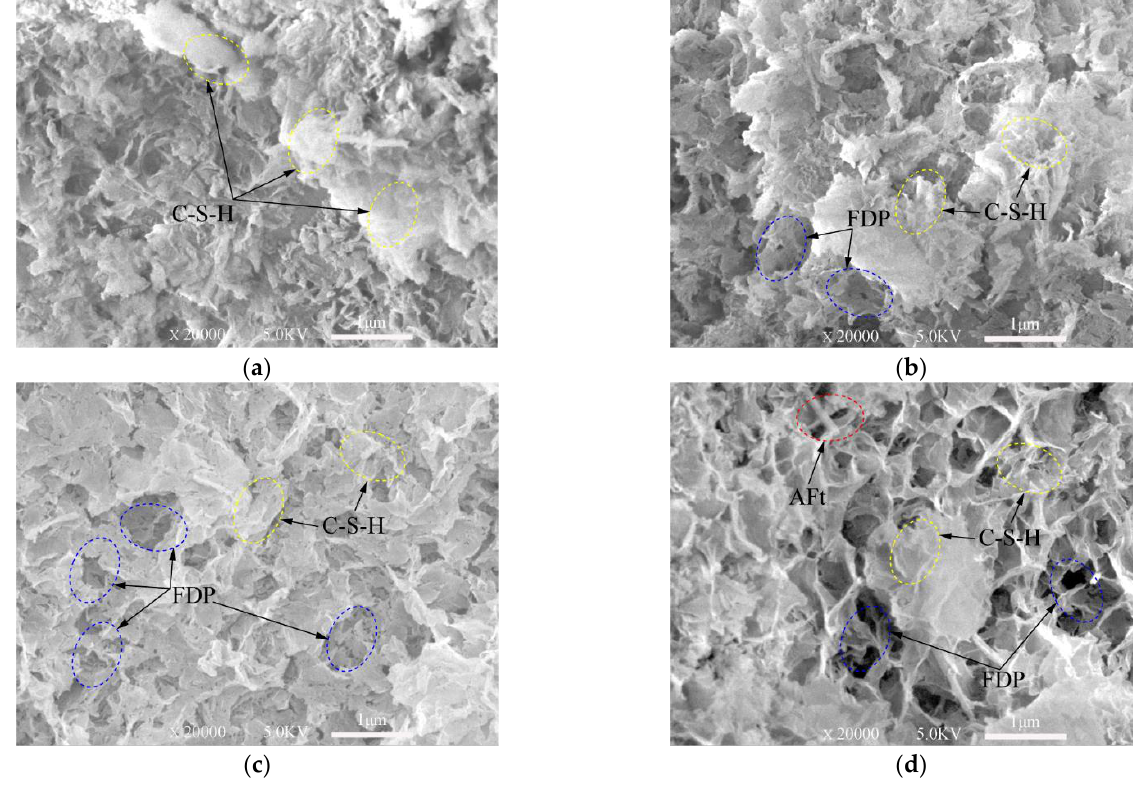
Figure 9. SEM images of 28-day samples under different freeze–thaw cycles. ( a ) Unfrozen; ( b ) After 5 freeze–thaw cycles; ( c ) After 10 freeze–thaw cycles; ( d ) After 20 freeze–thaw cycles. Note: Aft (Ettringite crystal); C-S-H (calcium silicate hydrate); FDP: freeze–thaw cycles damaged